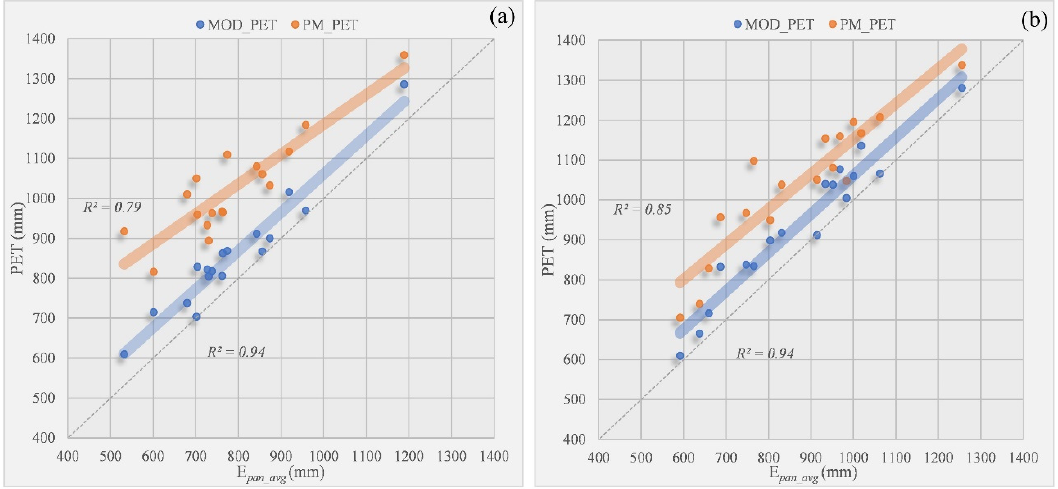
Figure 5. Correlation analysis of PM_PET and MOD_PET with E pan_avg for specified stations: ( a ) 2001–2009 and ( b ) 2010–2019.